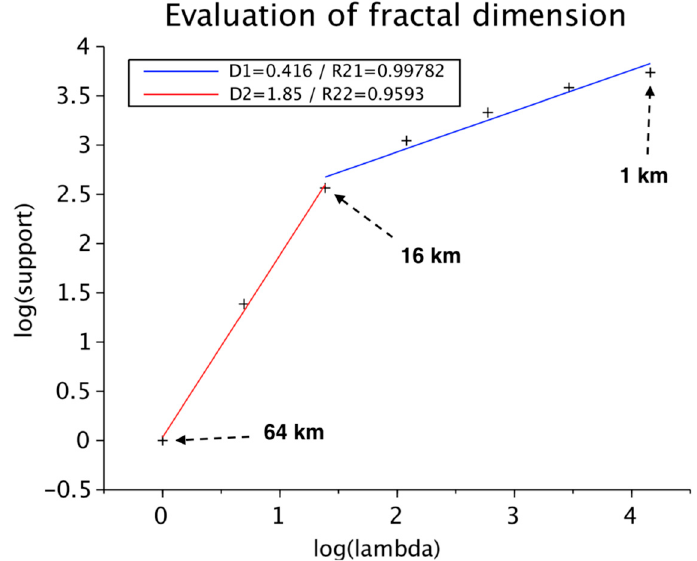
Figure 11. Fractal analysis of the rain gauges’ distribution (also called rainfall support) over the selected square area of the Muriaé River basin, where R21 and R22 represent the linear regression coefficients at the small and large scales, respectively.